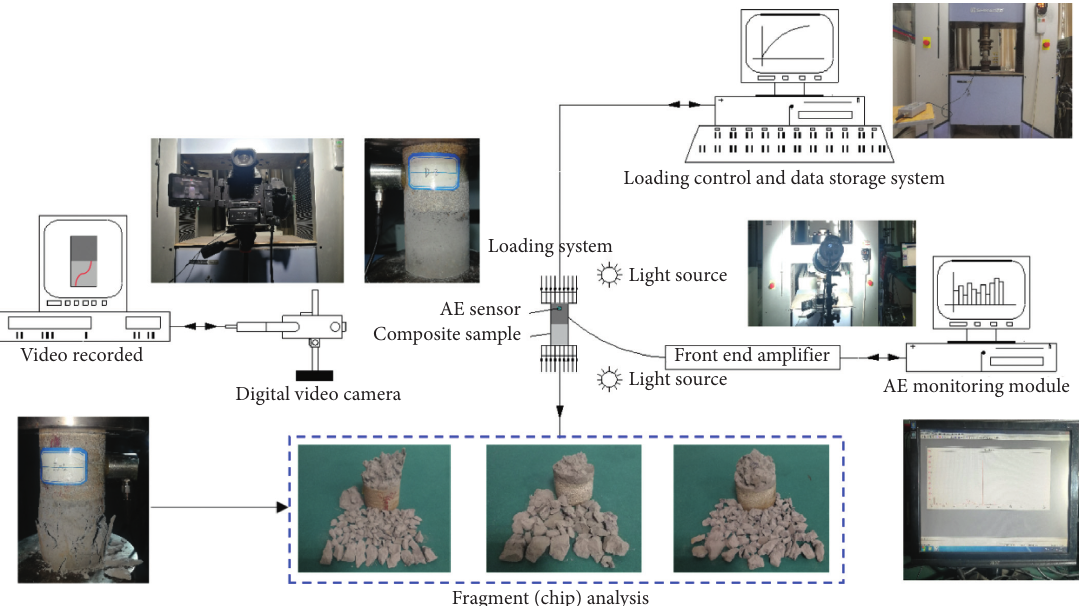
Figure 5: Test system for the composite